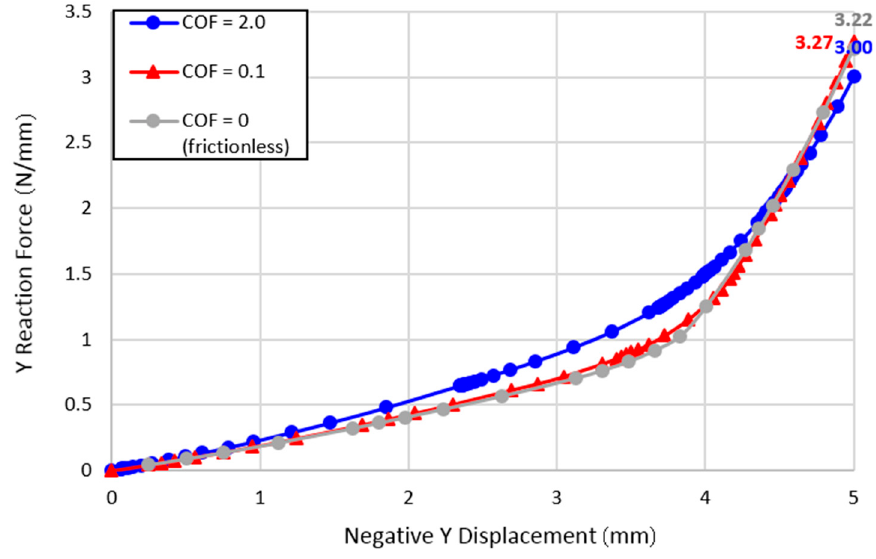
Figure 12. Effect of surface friction on vertical reaction force for multiple displacements.